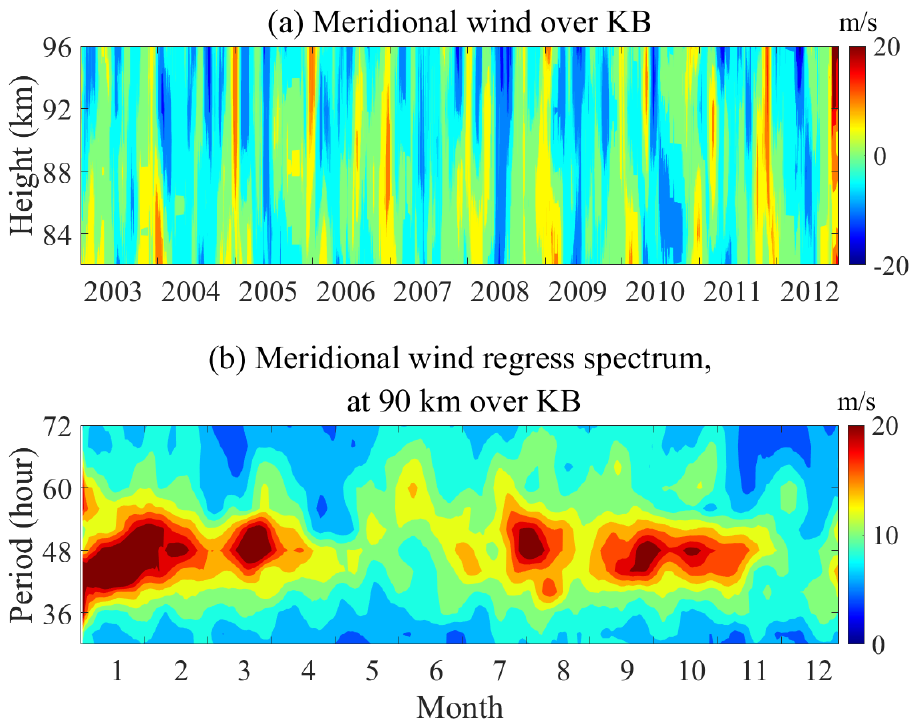
Figure 1. ( a ) The meridional wind obtained from meteor radar over KB from 2003 to 2012. ( b ) The averaged spectrum of meridional wind at 90 km over KB.